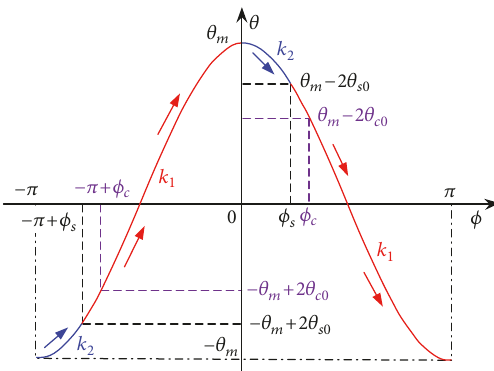
Figure 6: Vibration of 𝜃 in one